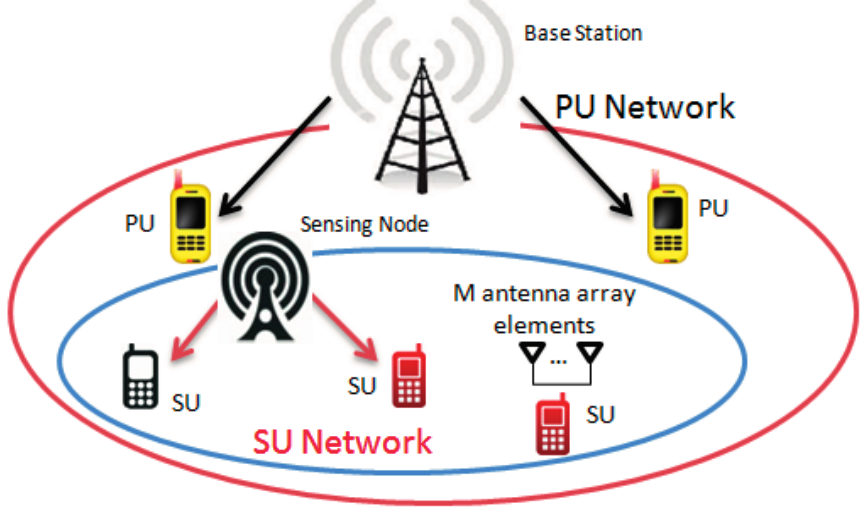
Figure 1. CR systems and SU with M antenna array